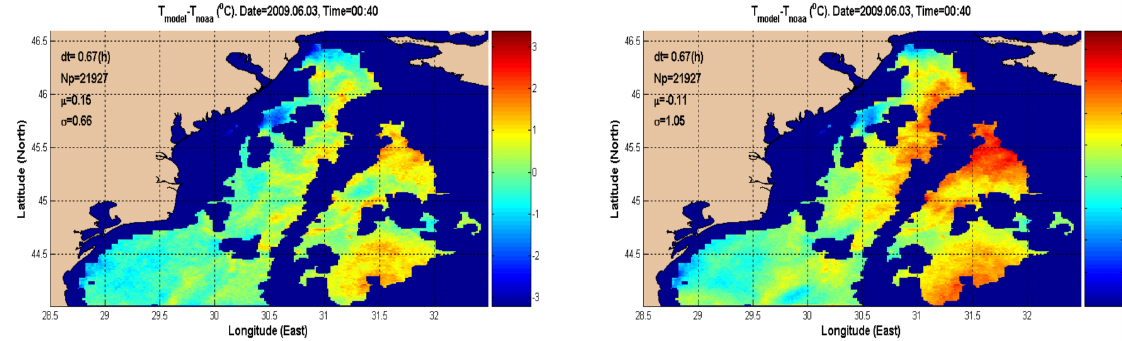
Fig. 15. Difference of simulated and observed SST fields on the north-western shelf of the Black Sea 3 June 2009. The nowcast is shown on the left panel and the 48h forecast is on the right one (dark blue – cloud occupied areas).